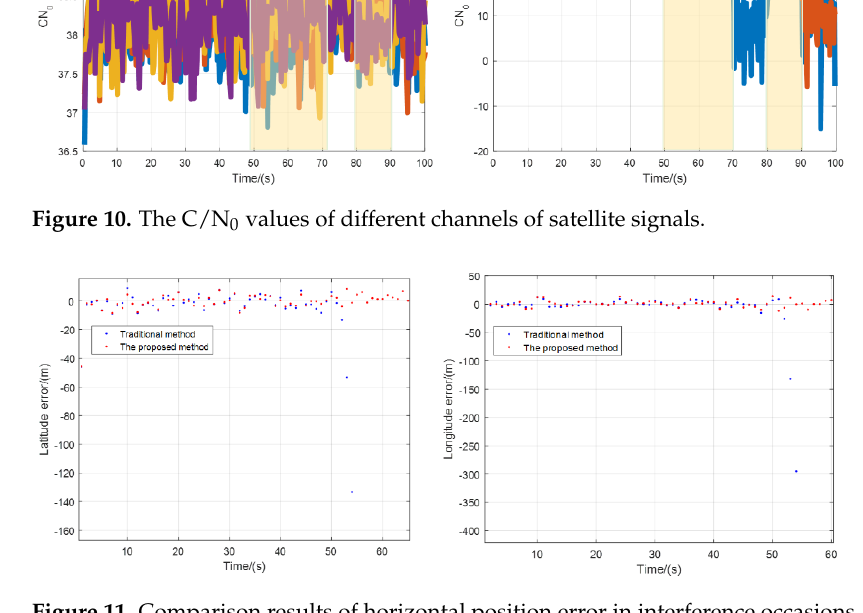
Figure 11. Comparison results of horizontal position error in interference occasions.